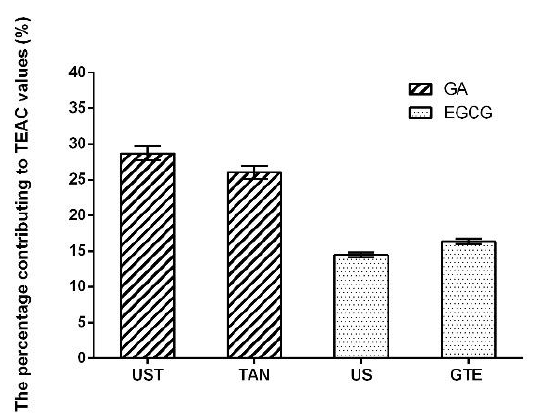
Figure 4. The percentage of gallic acid (GA) and epigallocatechin gallate (EGCG) contributing to the TEAC values of extracts for different treatments.